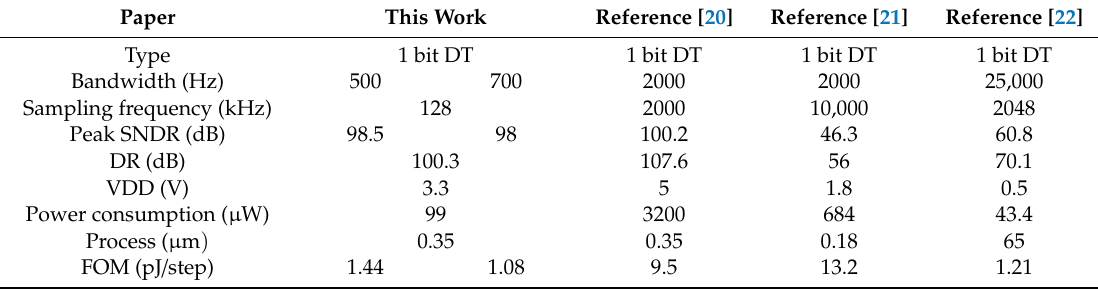
Table 5. Performance comparison of the